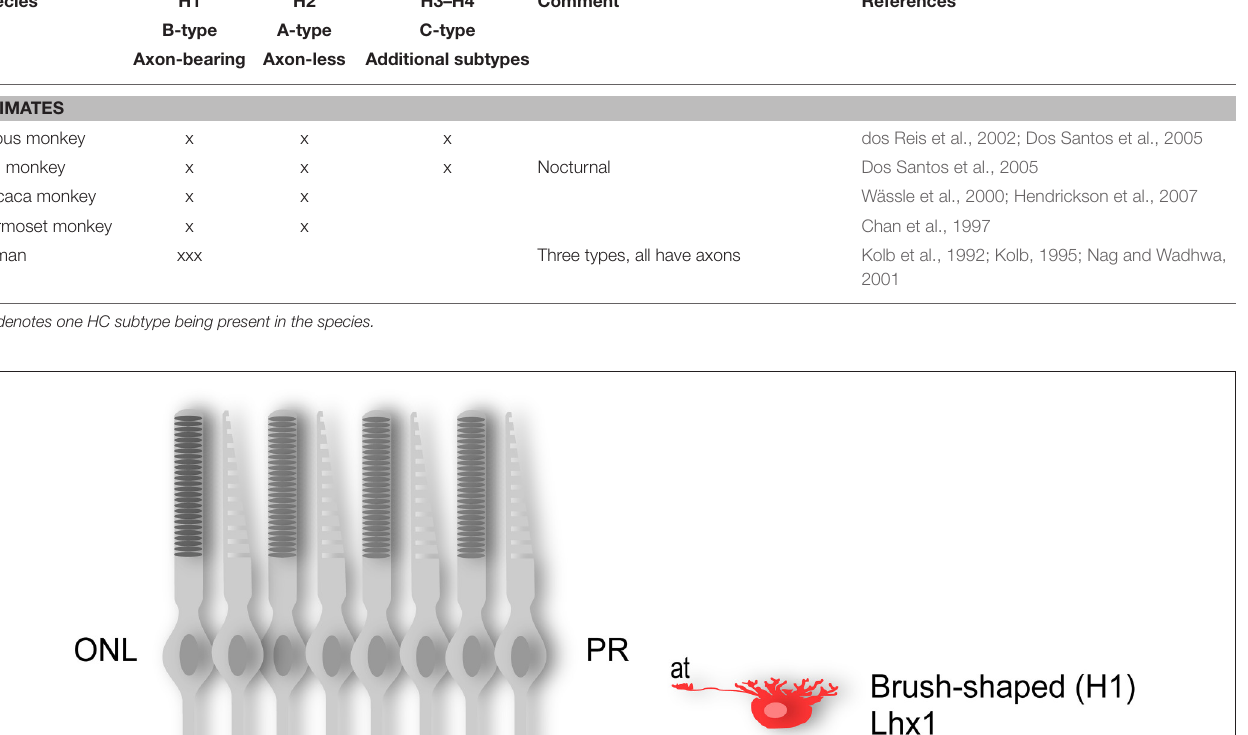
optic cup but is upregulated in a subset of cells that are Lhx1 positive suggesting a commitment down the HC path. Knock-out of the bHLH Ptf1a, a down-stream target of FoxN4, turned out to mimic the phenotype of the FoxN4 mutant with a complete loss of HCs and a drastic decrease of ACs (Li et al., 2004; Fujitani et al., 2006). Subsequent studies of FoxN4 and Ptf1a revealed that they are not only required, but also sufficient, for the generation